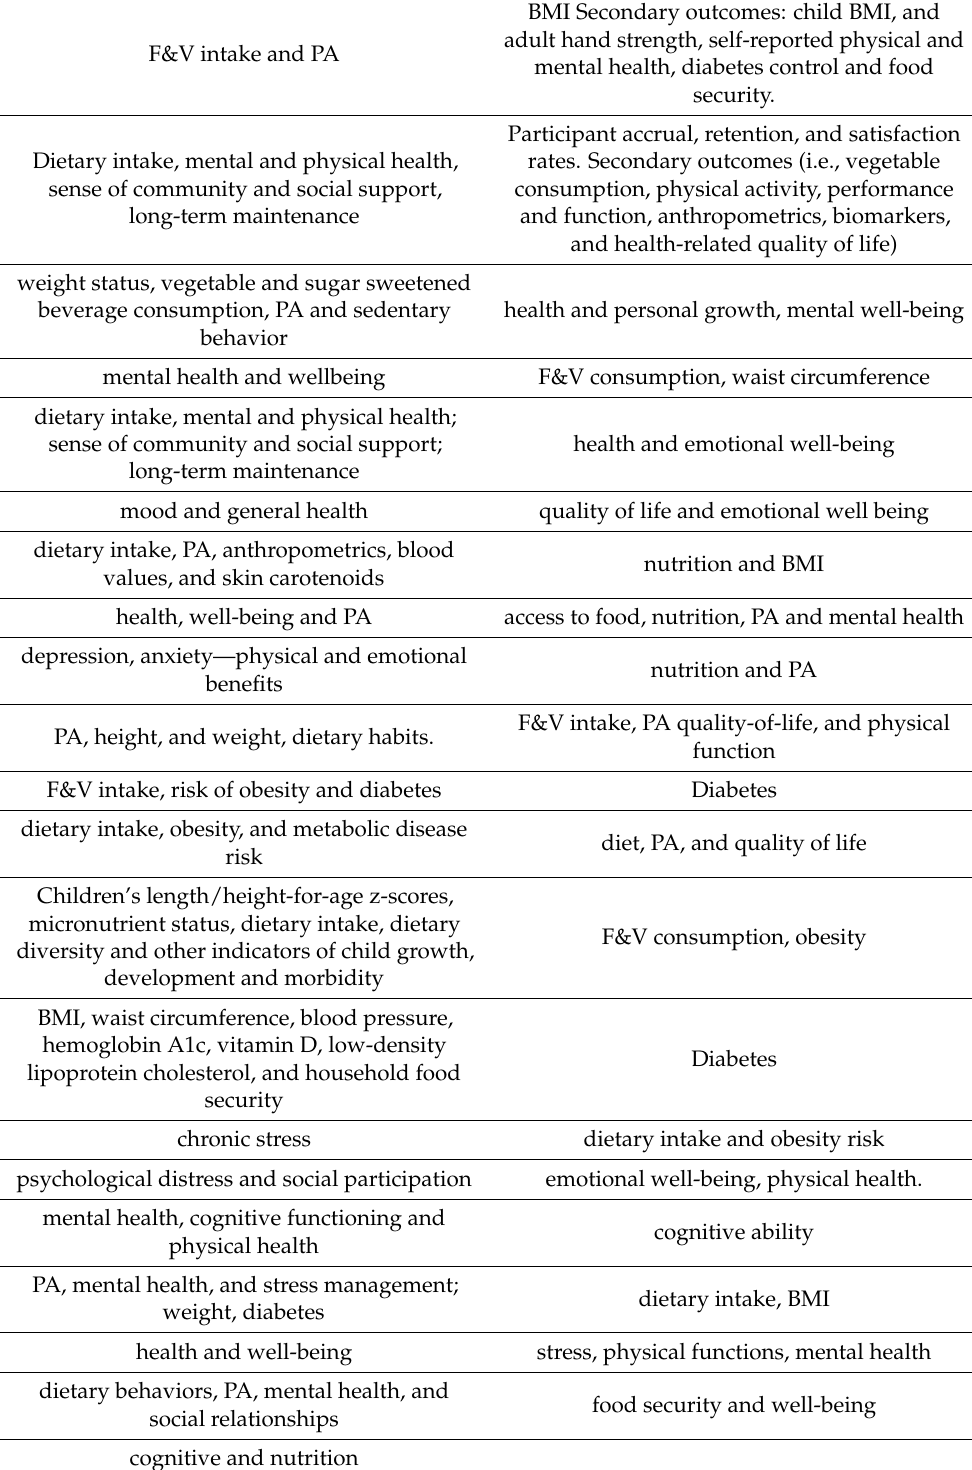
Table 1. Details of the main outcomes shown in studies with composite outcome definition (46.4% of the